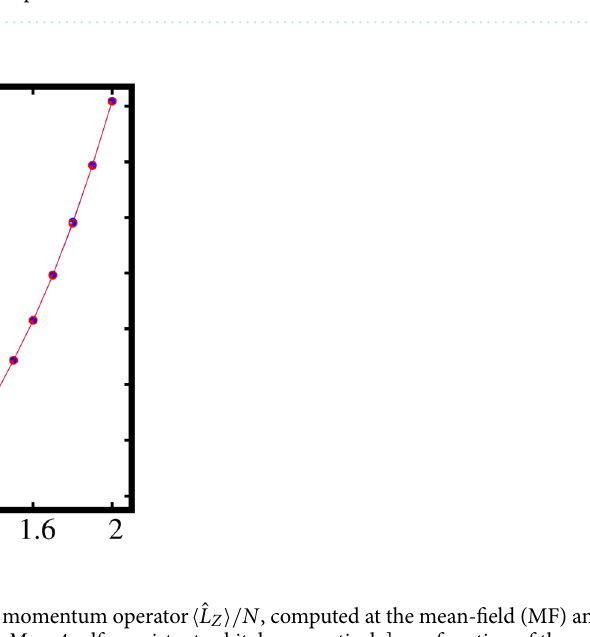
Figure 11. Rotation leads to four-fold fragmentation in the four-fold symmetric trap. M = 4 self-consistent orbitals are used. The variation of four natural occupations n 1 / N , n 2 / N , n 3 / N and n 4 / N are shown as a function of rotation frequency ω r . All quantities computed are dimensionless.